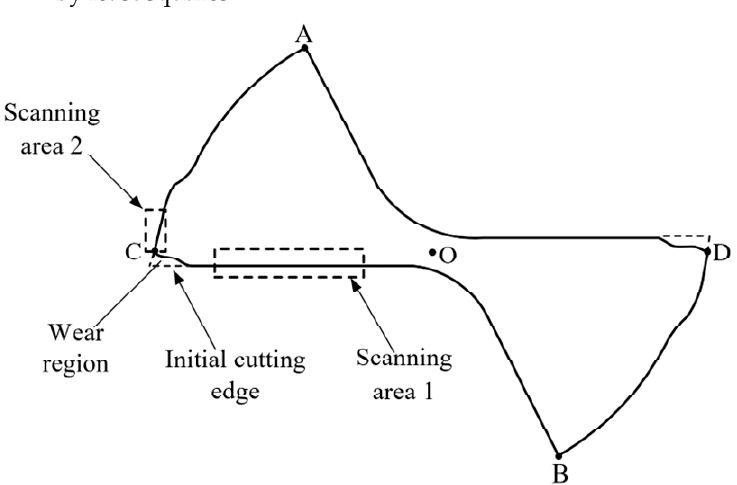
Figure 9. Schematic of tool wear region boundary reconstruction. Fitting and reconstructing lines using the least-squares polynomial fitting method is ca- pable of achieving subpixel-level positioning [26] and obtaining high precision detection